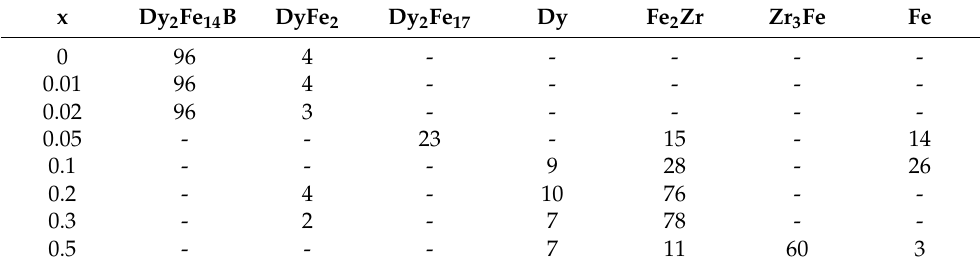
Table 1. Contributions of these phases (at.%) in [(Fe 80 Nb 6 B 14 ) 0.88 Dy 0.12 ] 1 − x Zr x determined from the XRD analysis. The estimated error of the phase content is about